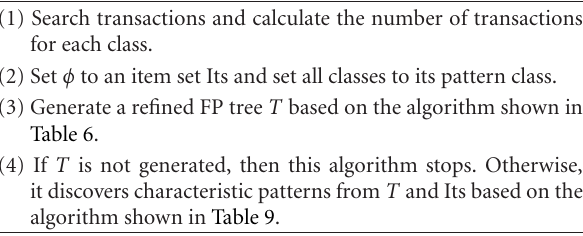
Table 9: An algorithm of the refined FP growth algorithm. Table 10: A discovery method of characteristic